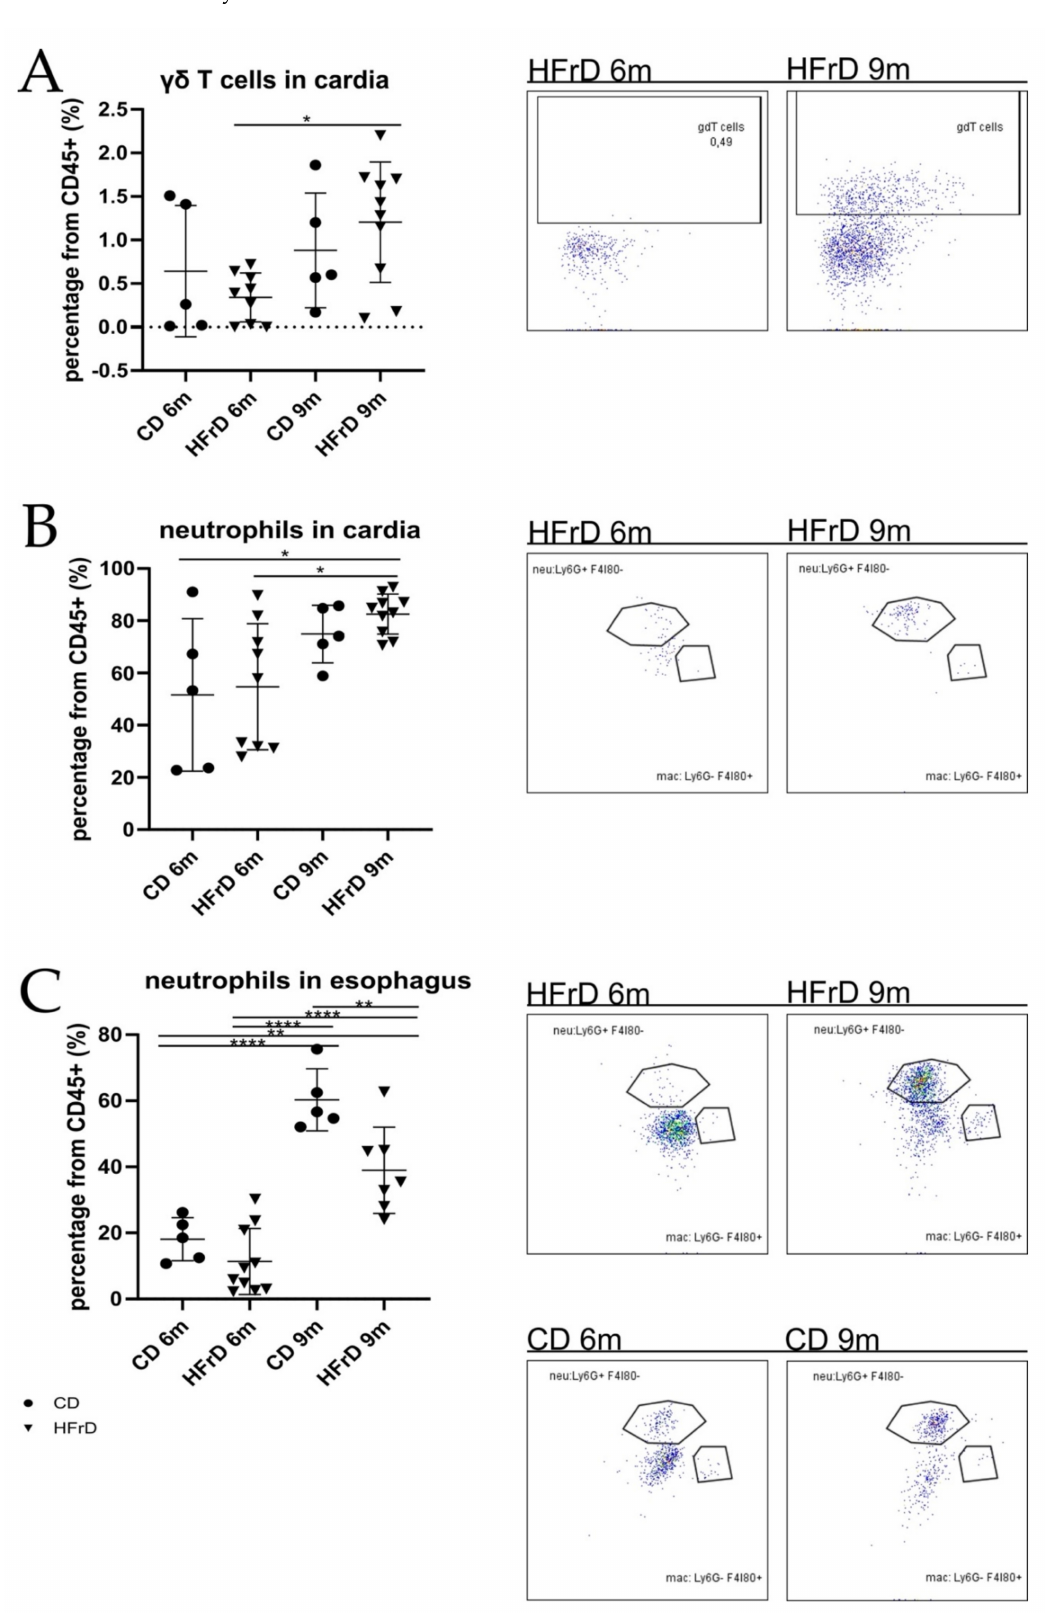
Figure 5. Myeloid and T cell populations in gastroesophageal tissues. ( A ) γδ T cell infiltration in cardia tissue. While